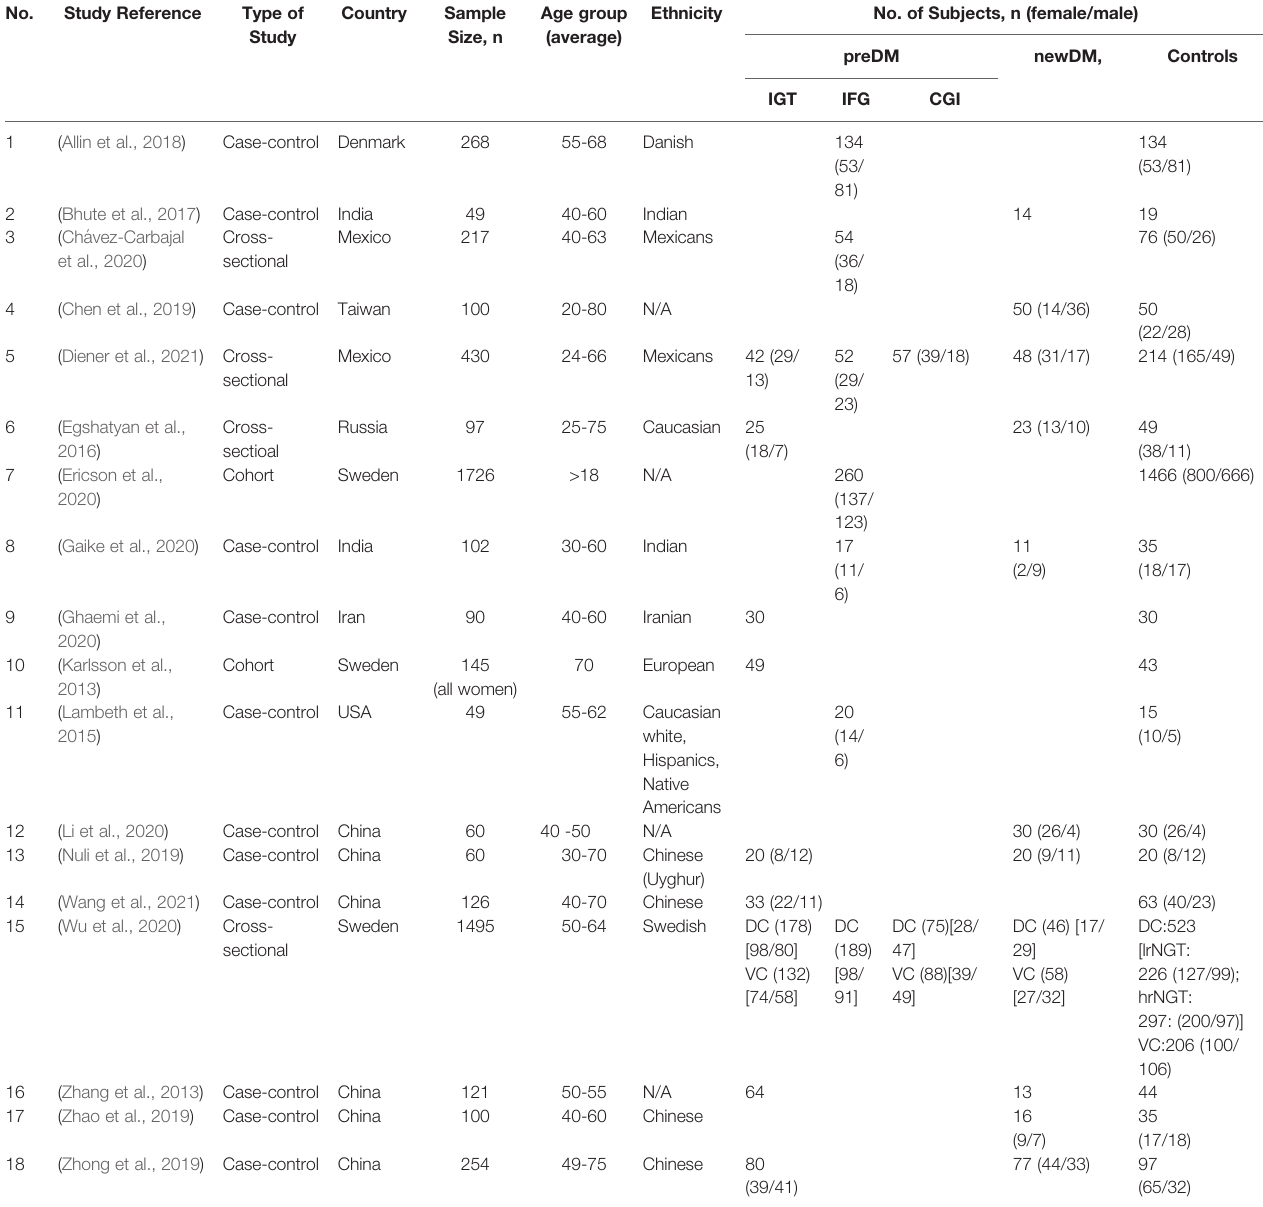
TABLE 2 | Summary of study